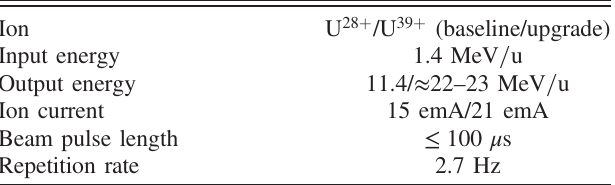
TABLE I. Main parameters of the proposed new high energy (HE) heavy – ion drift tube linac at